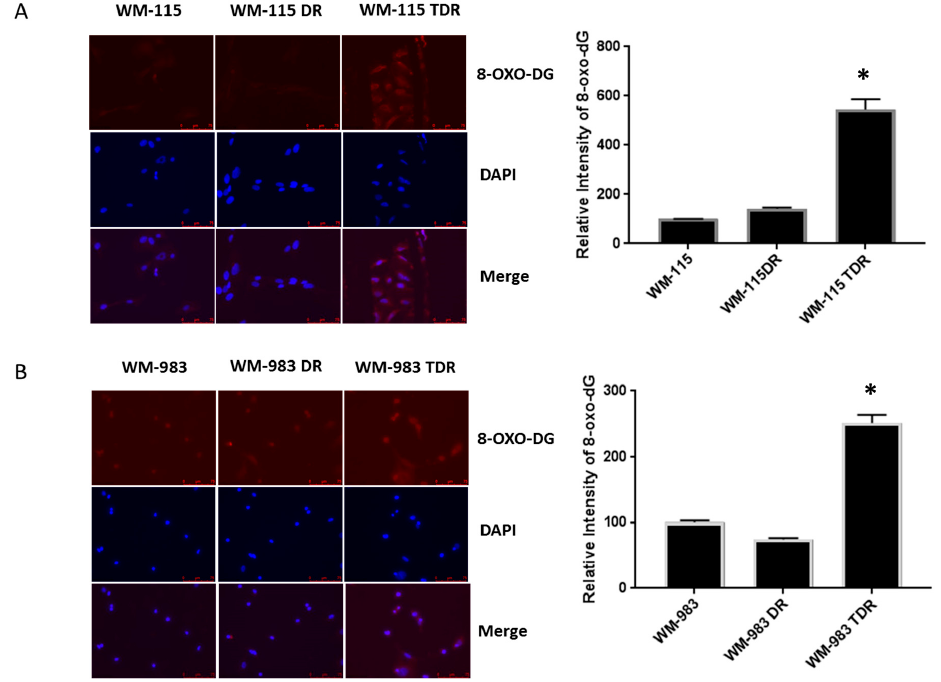
Figure 3. 8-oxodG, a DNA damage marker, is increased in BRAF pathway inhibitor-resistant melanoma cells. ( A ) Representative images showing anti-8-oxodG expression for WM-115 (parental, DR, and TDR) cell lines, as detected using immunofluorescent assay. 4 ′ ,6-diamidino-2-phenylindole (DAPI) stain is used to identify nuclei. Quantifications are shown on the right panel. ( B ) Representative images showing anti-8-oxodG staining for WM-983 (parental, DR, and TDR) cell lines, as detected by immunofluorescent staining. DAPI stain is used to identify nuclei. Quantifications are shown on the right panel. * p < 0.05 versus parental cell lines. Statistical analysis by one way ANOVA. 2.4. SOD2 and NF- κ B Levels Are Increased in BRAF Pathway Inhibitor-Resistant Melanoma Cells